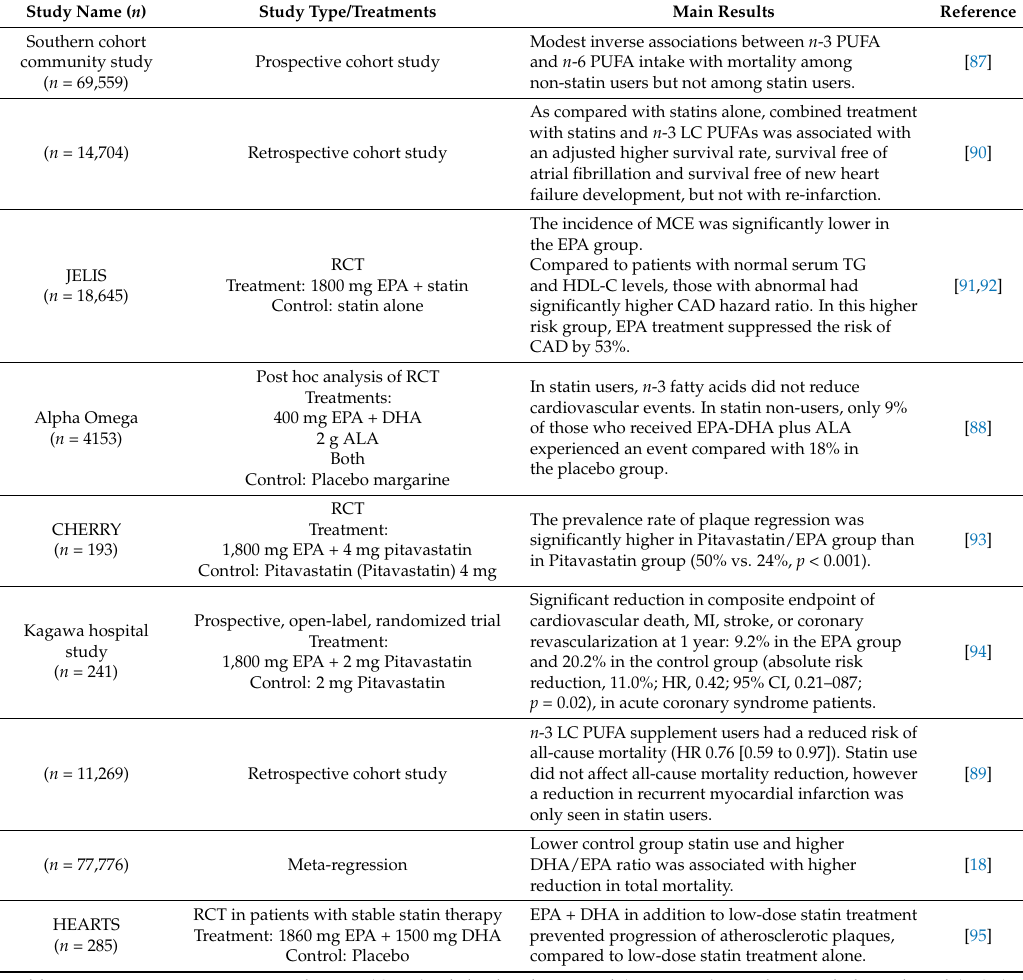
Table 2. Clinical studies with a combination of n -3 LC PUFAs and